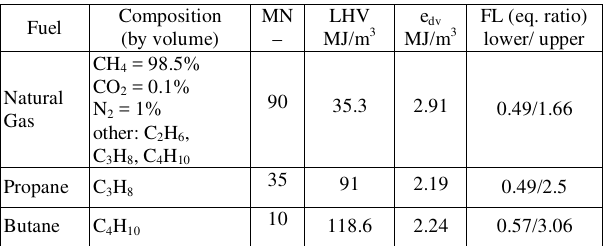
Table 1. Properties of natural gas and propane and butane